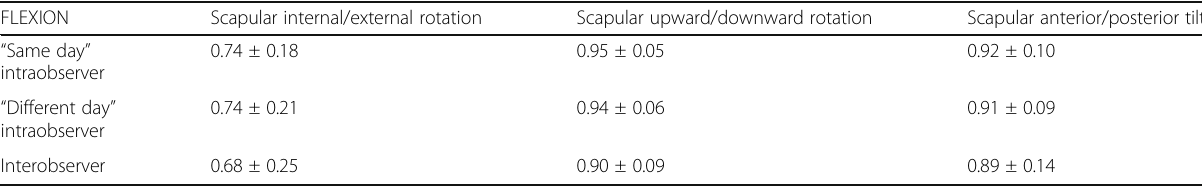
Table 2 CMC values for reproducibility of the scapular angles during shoulder flexion. The data is presented as mean ± standard deviation. Most measurement presented very good reproducibility (CMC > 0.75) with moderate reproducibility (CMC between 0.65 and 0.75) for interobserver agreement in scapular internal-external